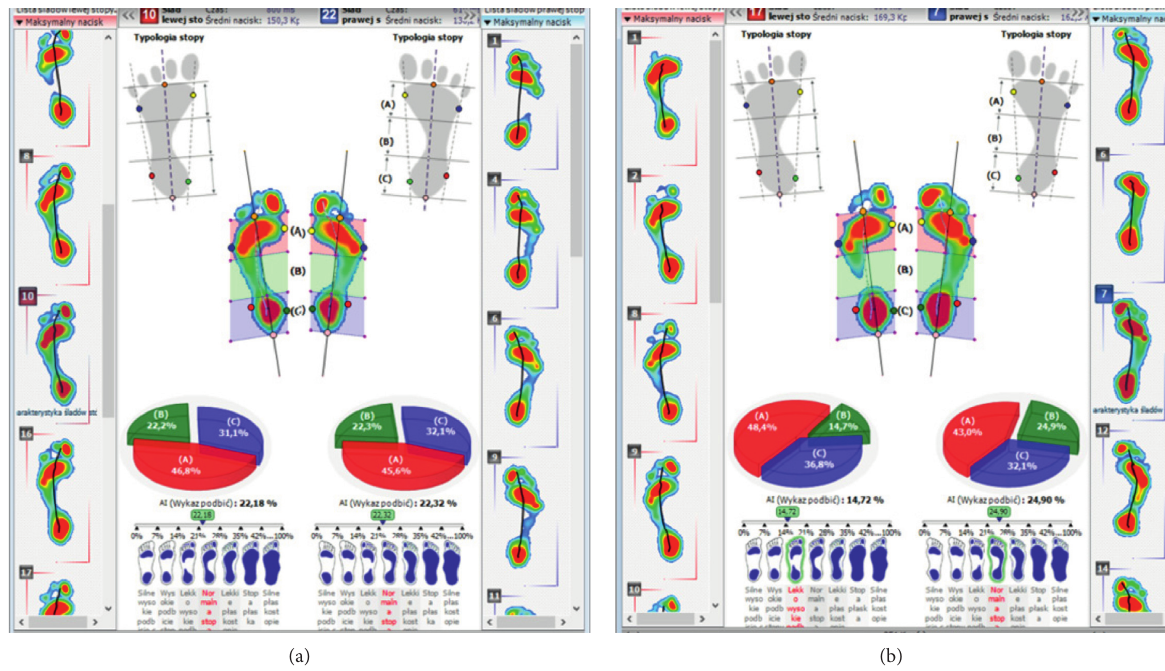
Figure 6: (a) The results of the AI test before repositioning the mandibular head in the articular fossa and stabilizing the position of the condylar process with a temporary silicone occlusal splint, in an exemplary patient, during walking. (b) The results of the AI test after repositioning the mandibular head in the articular fossa and stabilizing the position of the condylar process with a temporary silicone occlusal splint, in an exemplary patient, during